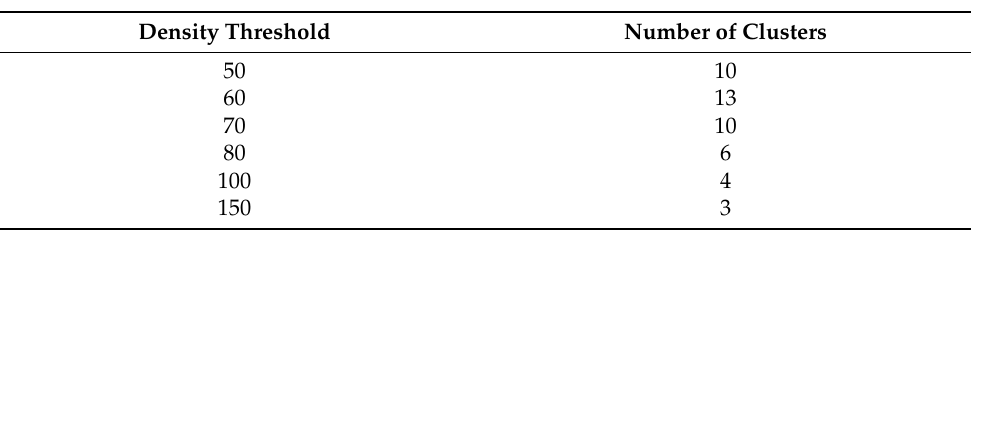
Table 5. Radius length =